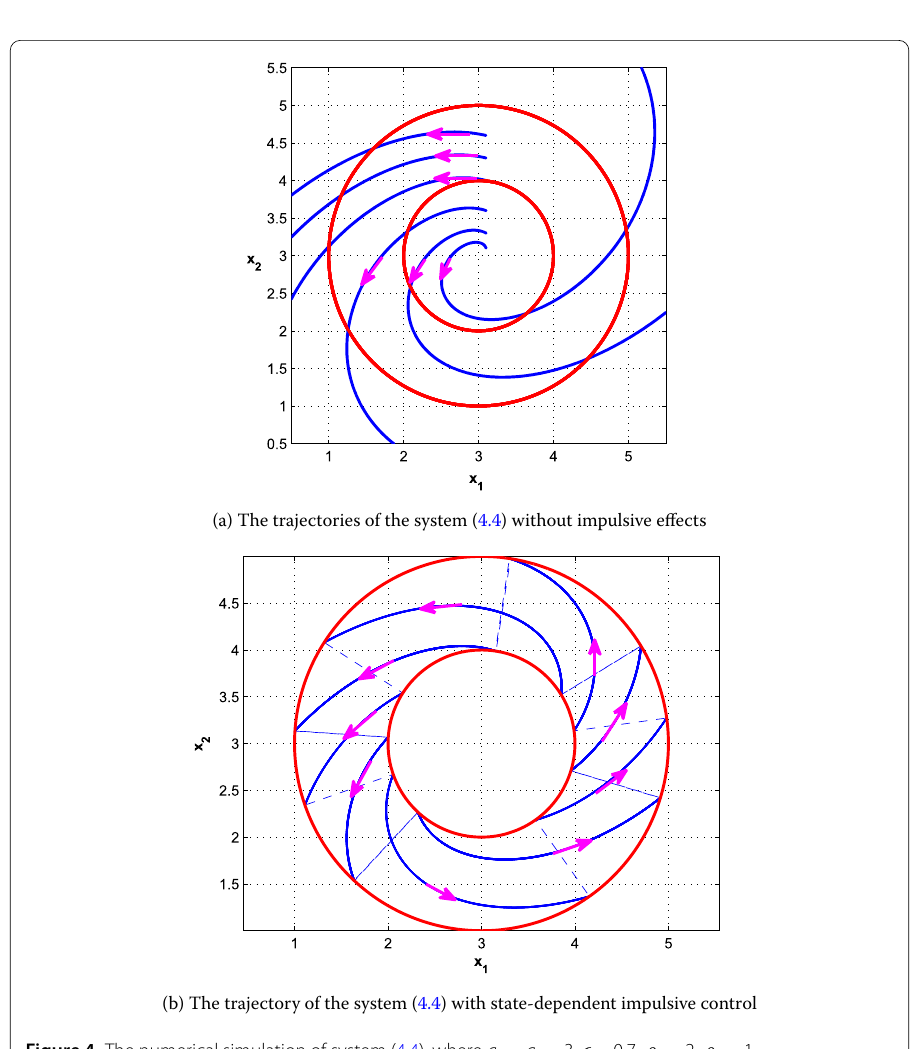
Figure 4 The numerical simulation of system (4.4), where a 1 = a 2 = 3, (cid:15) = 0.7, ρ 1 = 2, ρ 2 =